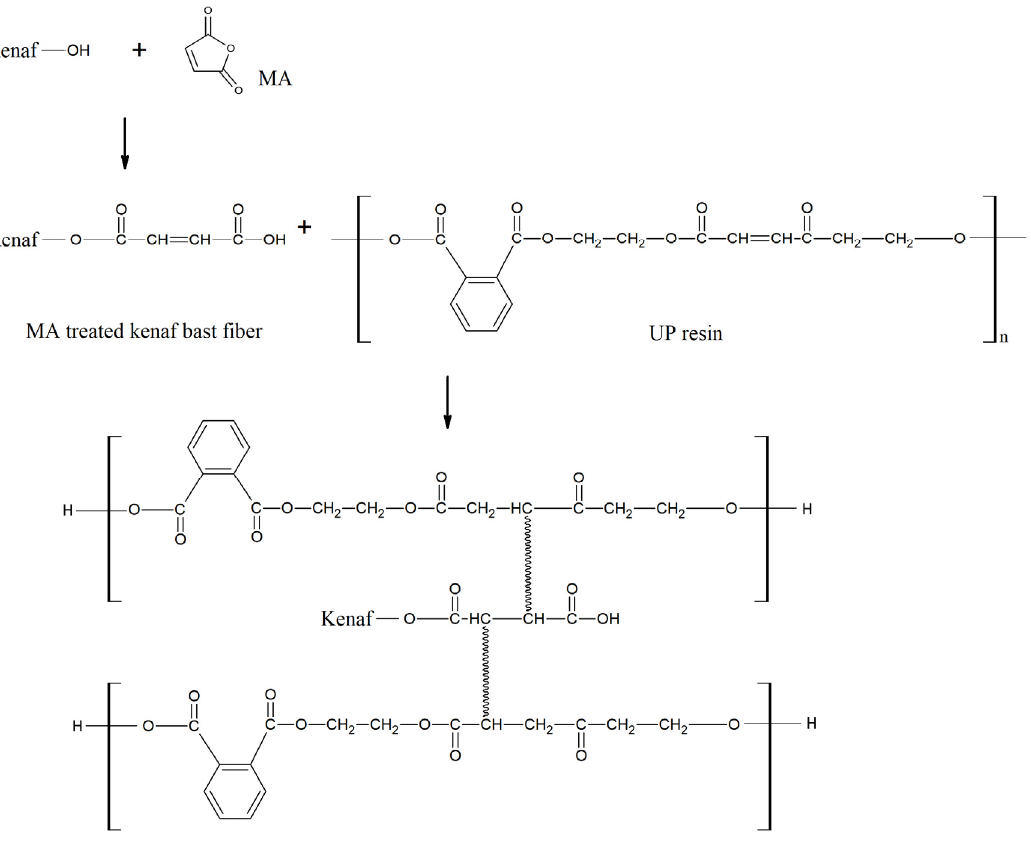
Figure 5. Reaction of MA-treated KBF and UPE resin.